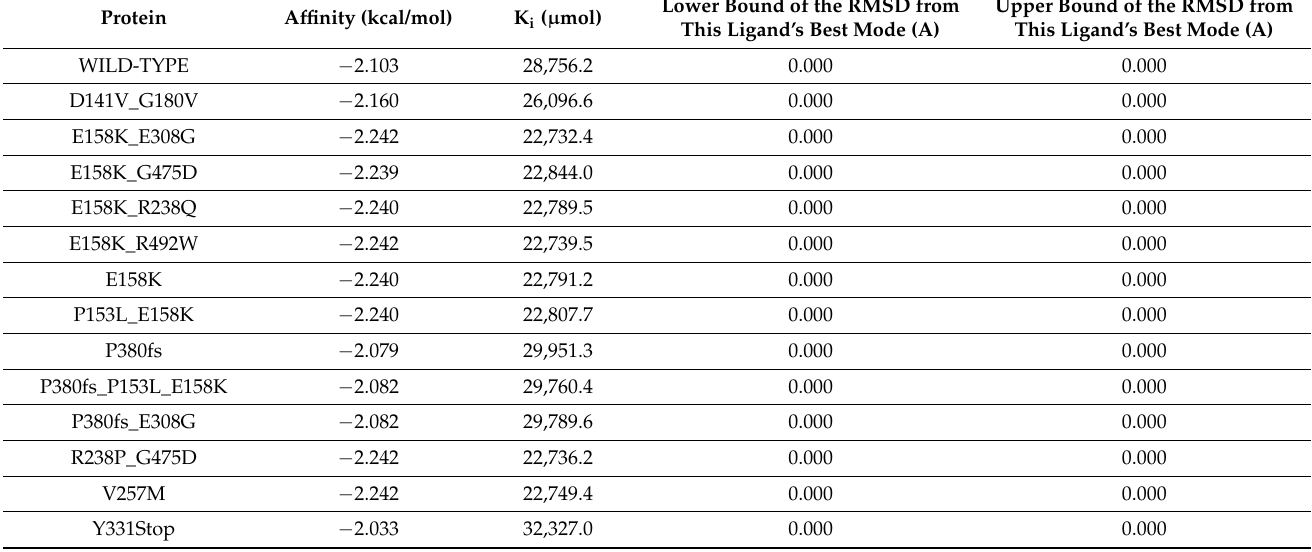
Table 4. Best significant modes of TMA/ FMO3 docking models. AutoDock Vina permitted to compute 10 different modes for docking analysis between TMA and FMO3 . This table shows the most reliable models, based on energetic variables. K i = inhibition constant. RMSD values are calculated relative to the best mode (the first model) and use only movable heavy atoms (i.e., only ligand atoms, not hydrogen). RMSD upper bound matches each atom in one conformation with itself in the other conformation, ignoring any symmetry. RMSD lower bound matches each atom in one conformation with the closest atom of the same element type in the other